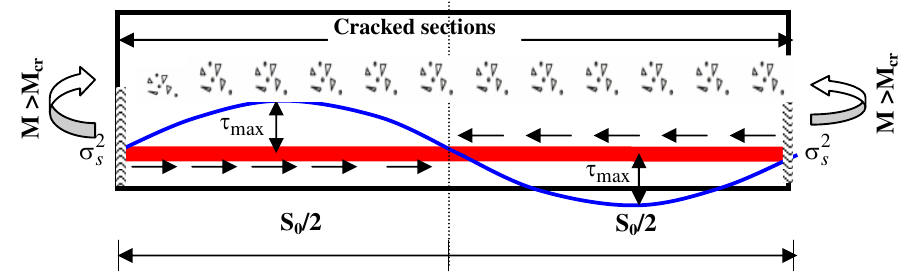
Fig. 5. Bond stress between adjacent cracked sections in constant moment case